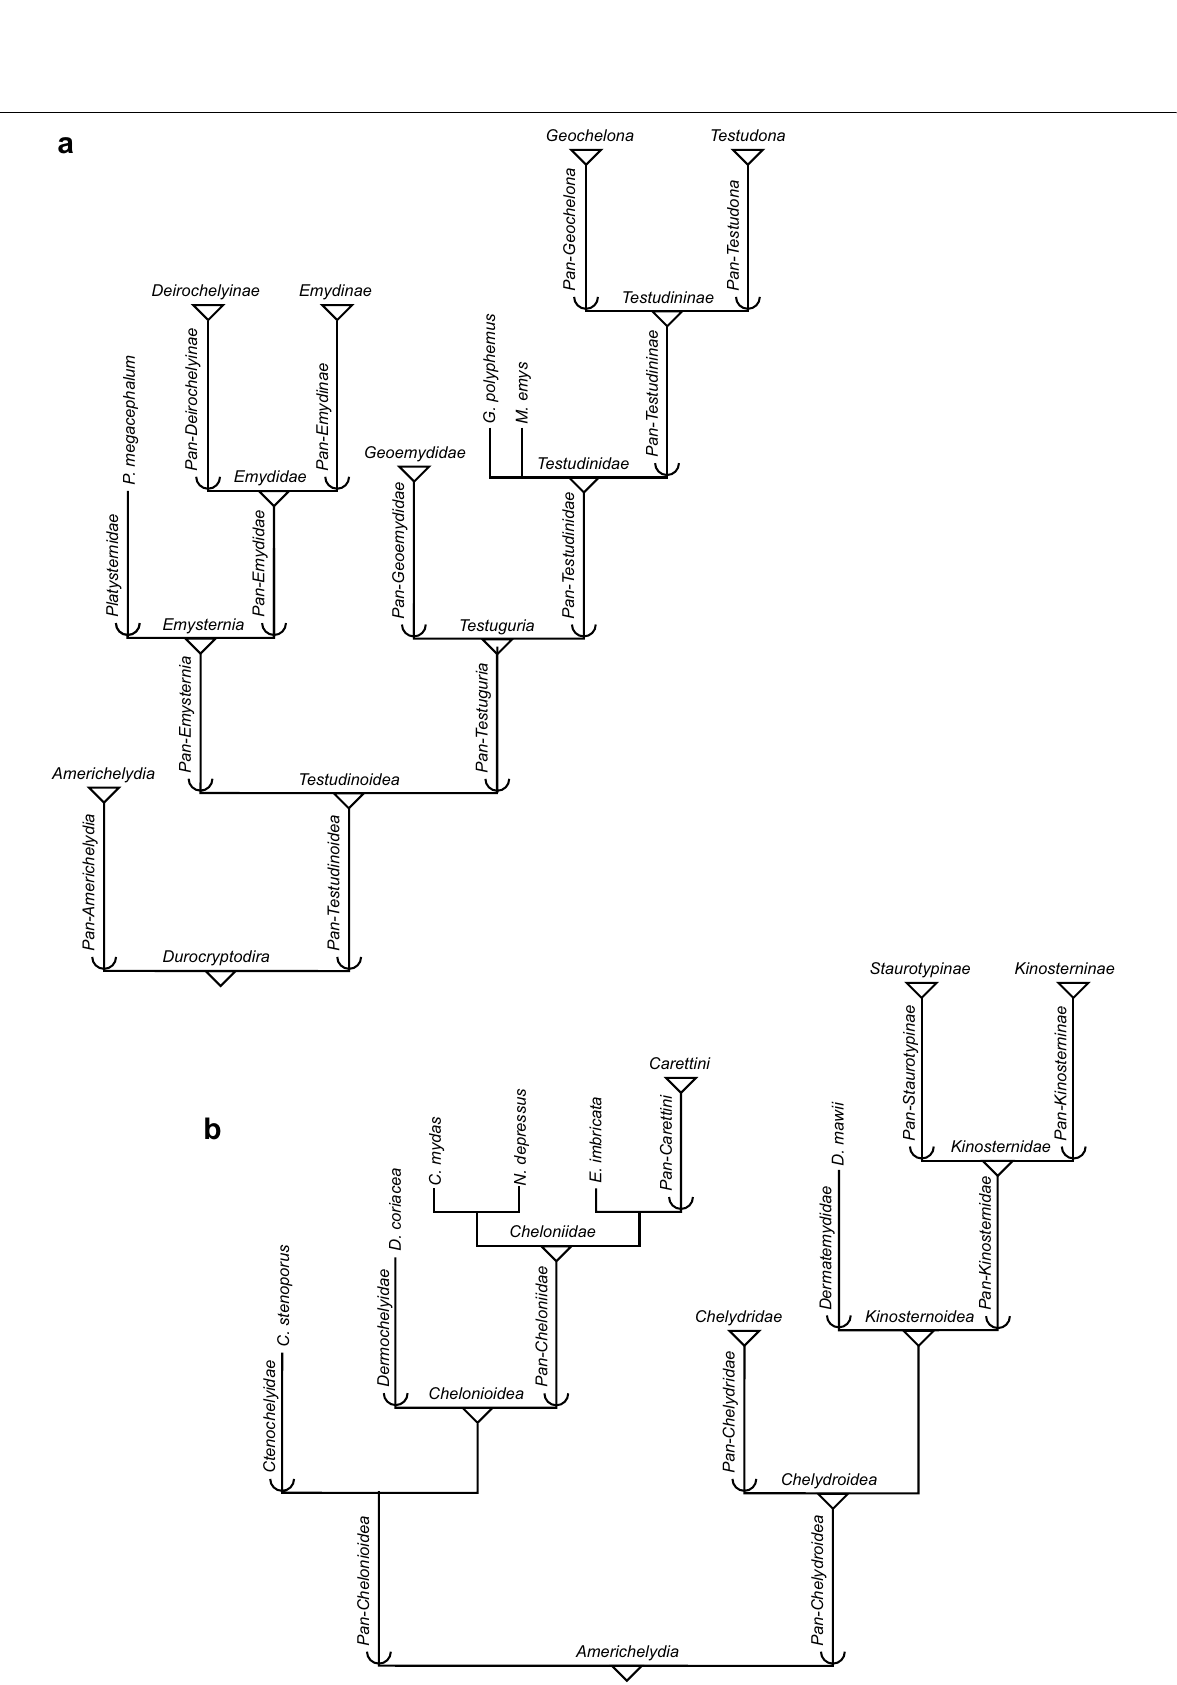
Fig. 4 Simplified diagrams that highlight the proposed name usage of clade names within a Durocryptodira and b